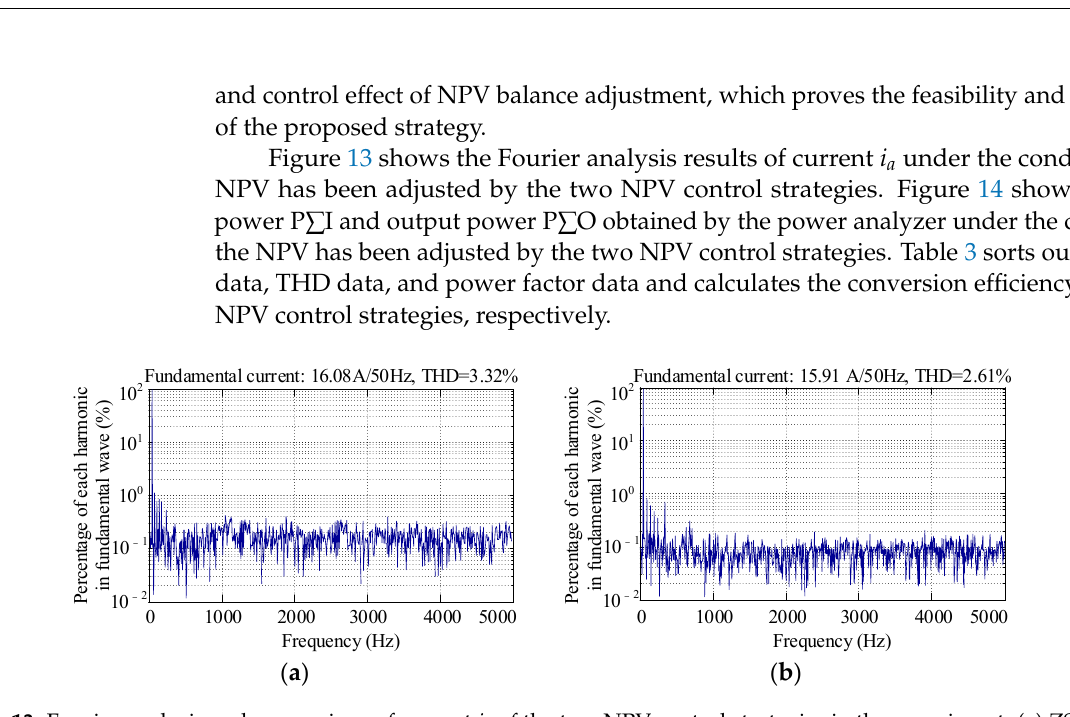
Figure 12. Performance comparisons of the two NPV control strategies when the two loads are unequal. ( a ) ZSV-J; ( b ) the proposed NPV control strategy.